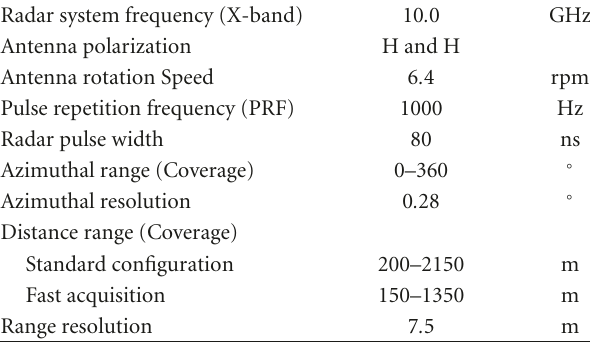
Table 1: Transmission and reception characteristics of the maritime radar